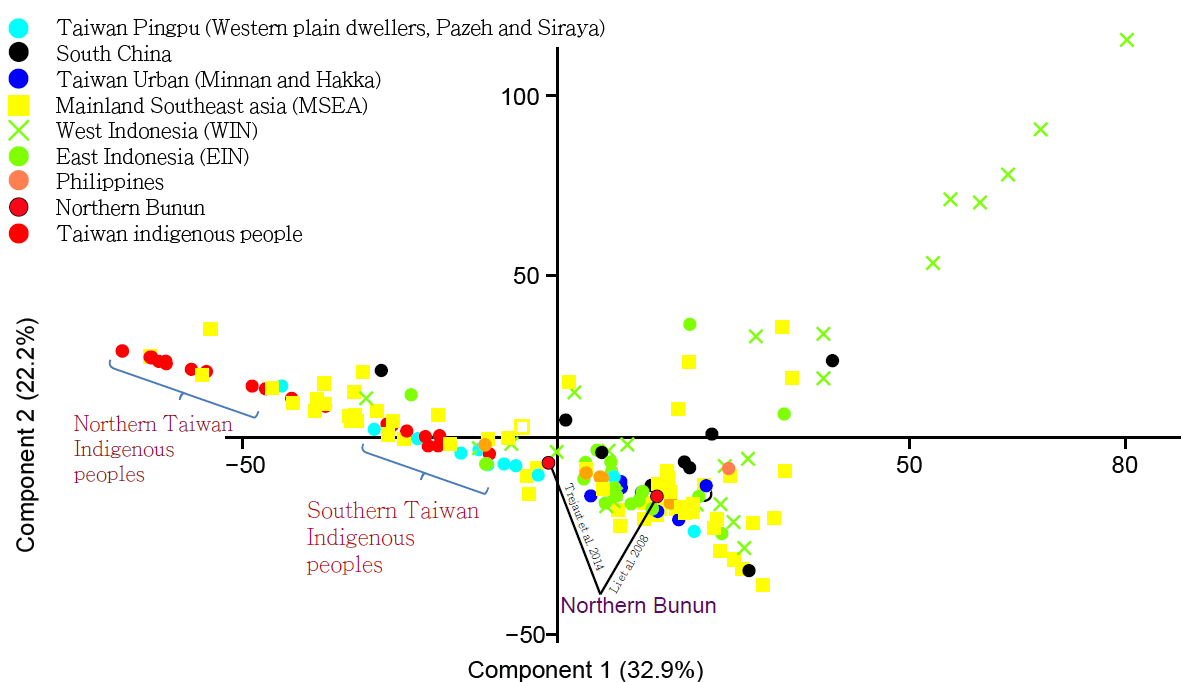
Figure 5. Principal component analysis using NRY haplogroup polymorphism. Note: The Y Chromosome of two Northern Bunun samples [25,32] are shown separately. Reference data for other groups were obtained from the literature (including an East African group used as an out-group [63,64].